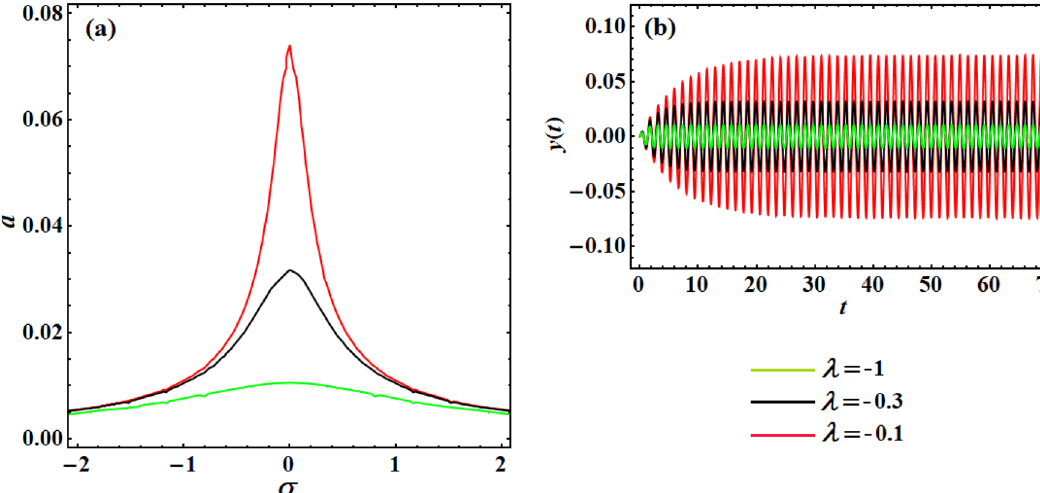
Figure 9. Illustrates the effect of positive linear-velocity feedback gain of the system frequency–response curve when the loop-delay is zero: ( a ) shows the impact of the linear-velocity gain (cid:31) , while ( b ) reveals the system time response when (cid:31) ( = − 1, − 0.3, − 0.1 )